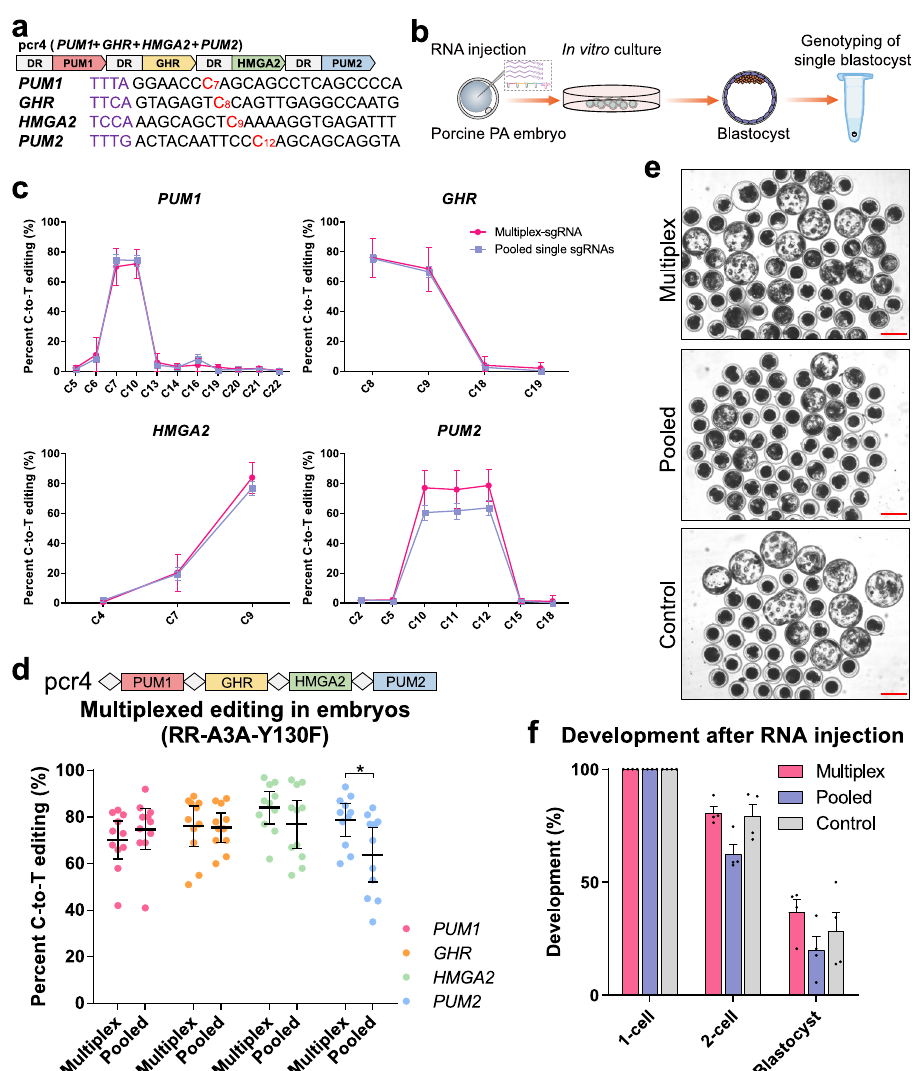
Fig. 4 Multiplexed base editing by Cas12a variant-mediated base editors in embryos. a Construct of CRISPR array of pcr4 with four tandem sgRNAs targeting to porcine genome. The sequences of individual targets are listed below. PAMs are marked in purple and target Cs are marked in red. b Schematic illustrating the work fl ow of RNA mixture microinjection of porcine parthenogenetic (PA) embryos to assess the editing ef fi ciency. c Simultaneous C-to-T editing of four loci ( PUM1 , GHR , HMGA2 , and PUM2 ) by RR-A3A-Y130F with multiplex-sgRNA (CRISPR array pcr4) or pooled single sgRNAs in porcine PA embryos ( n = 11). d Ef fi ciencies of C-to-T editing of target Cs (marked in red in a ) induced by RR-A3A-Y130F at four indicated loci ( n = 11). e Representative images of porcine PA embryos development in vitro six days after RNA injection, with uninjected PA embryos as the control ( n = 4). Scale bar, 200 µ m. f Development of porcine PA embryos in vitro after RNA injection ( n = 4). Values and error bars for c and f represent the mean and SEM, respectively. Values for d represent the median with interquartile range. Statistical signi fi cance was calculated by unpaired two-tailed Student ’ s t -test (* p